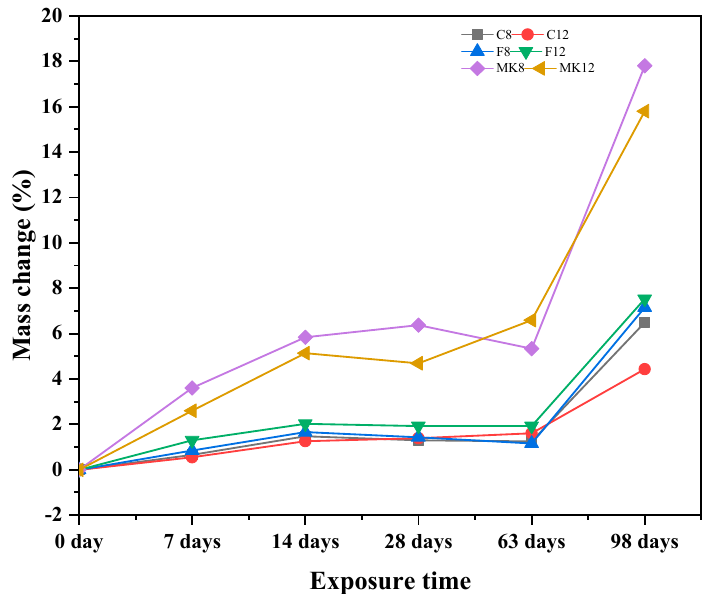
Figure 5. Mass loss of different GPCs exposed to sulfuric acid solution.